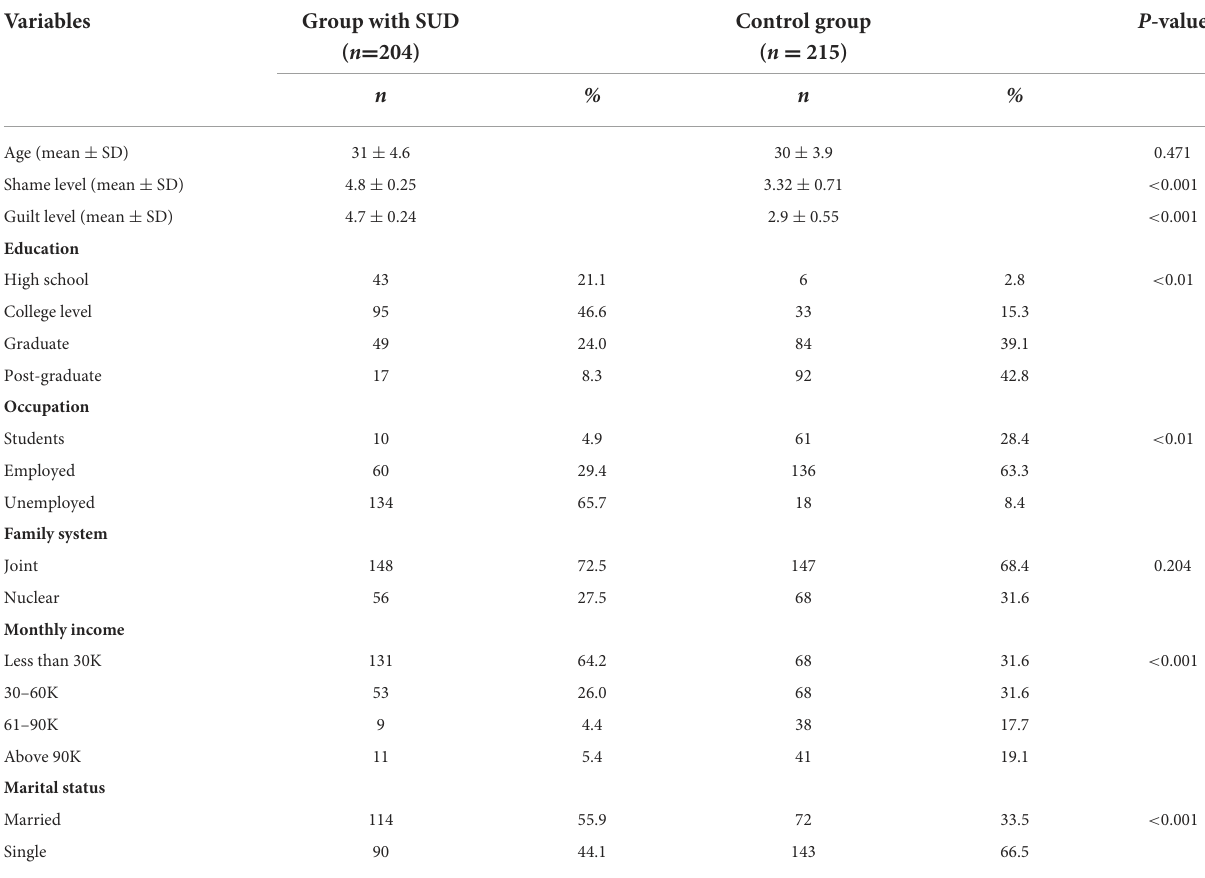
TABLE 1 Sociodemographic characteristics between the group with SUD and control group. Variables Group with